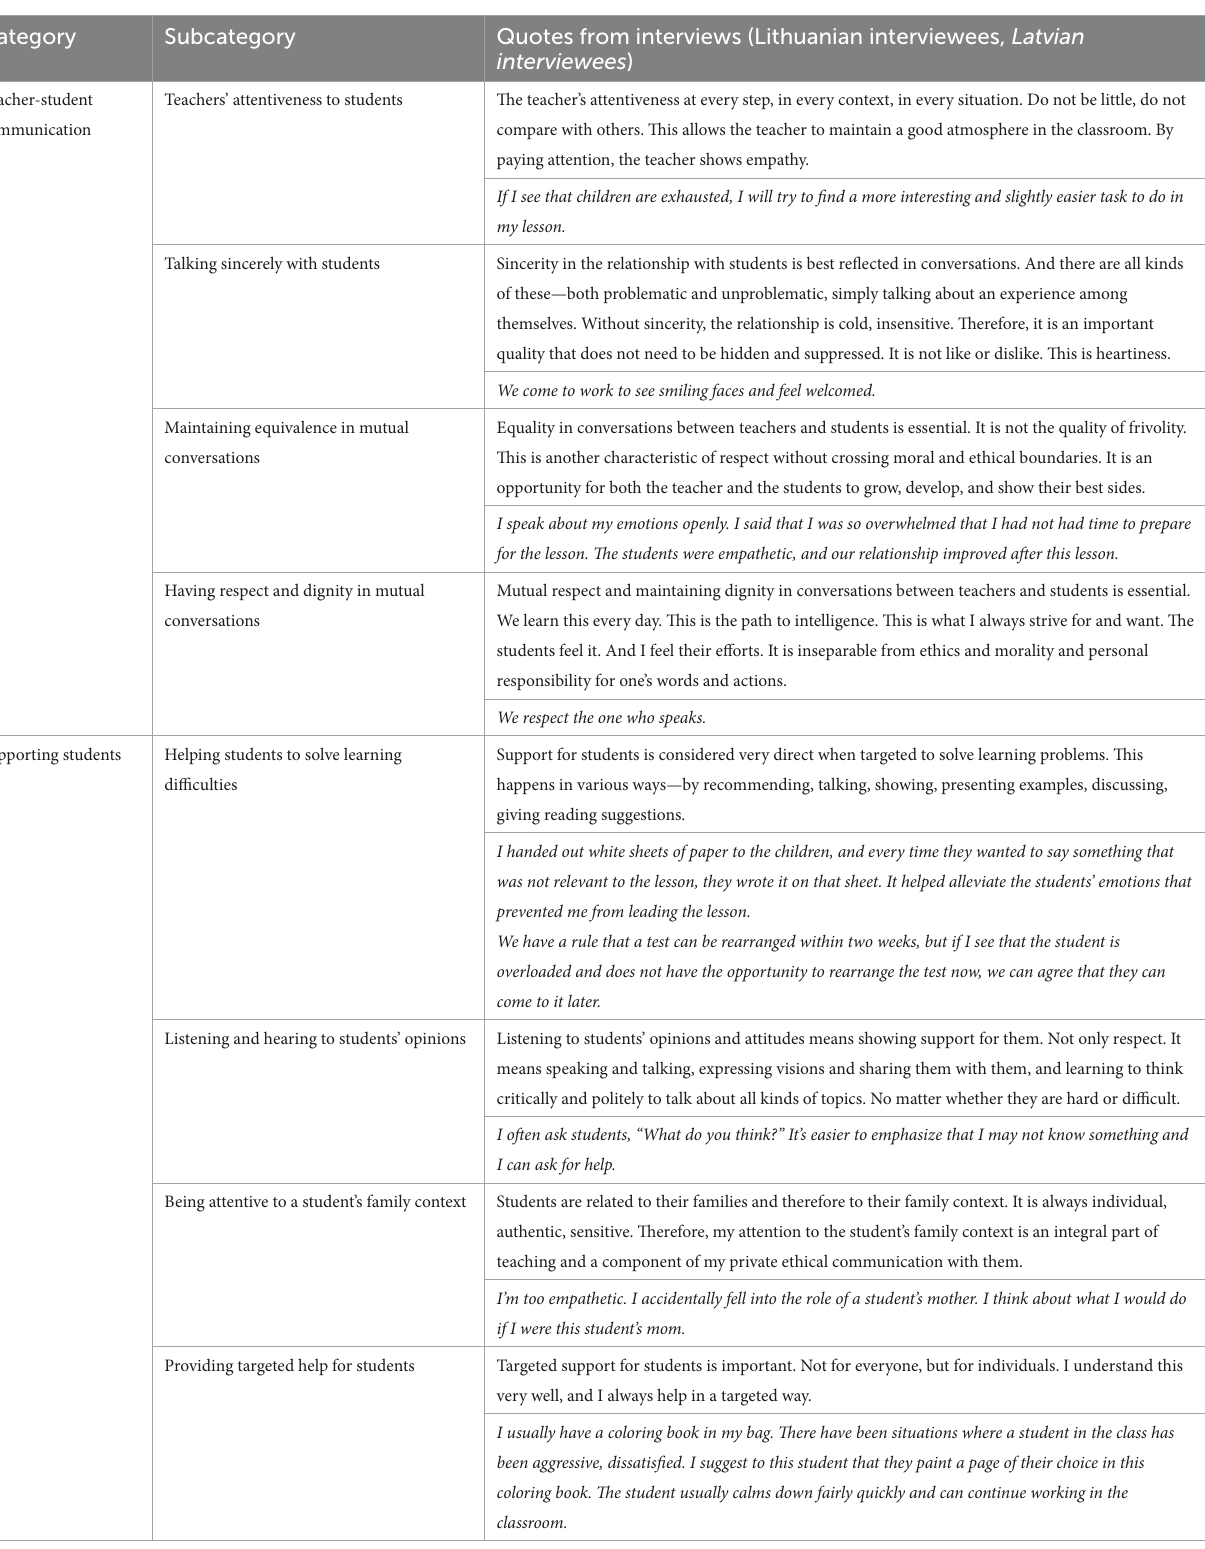
TABLE 3 Content of similar categories in Latvian ( n = 83) and Lithuanian ( n = 69) teachers’ answers to the question “How do you use empathy in your work?” Category Subcategory Quotes from interviews (Lithuanian interviewees, Latvian interviewees